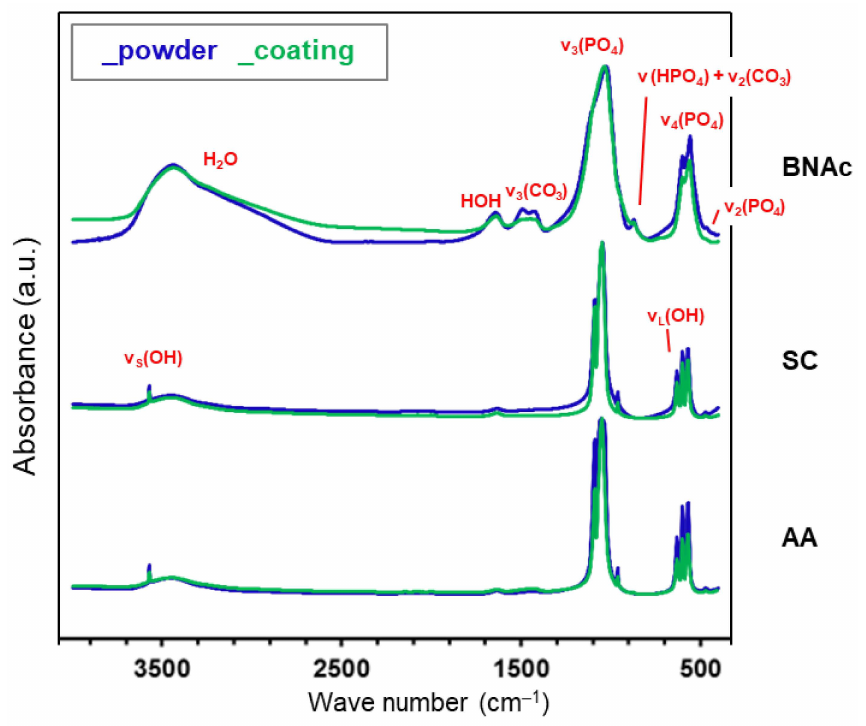
Figure 6. FTIR analysis: comparison between the powder and coating